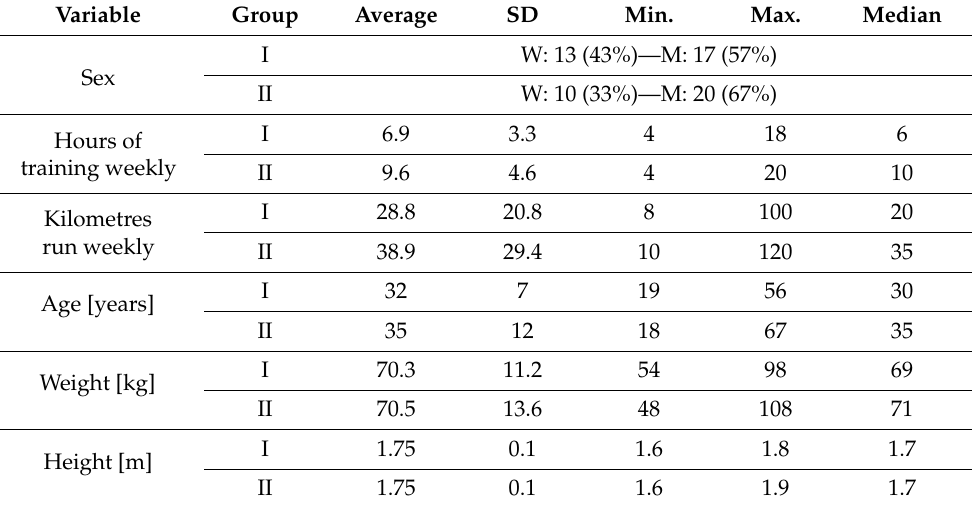
Table 1. The descriptive statistics of chosen variables broken down by the control and test group. Variable